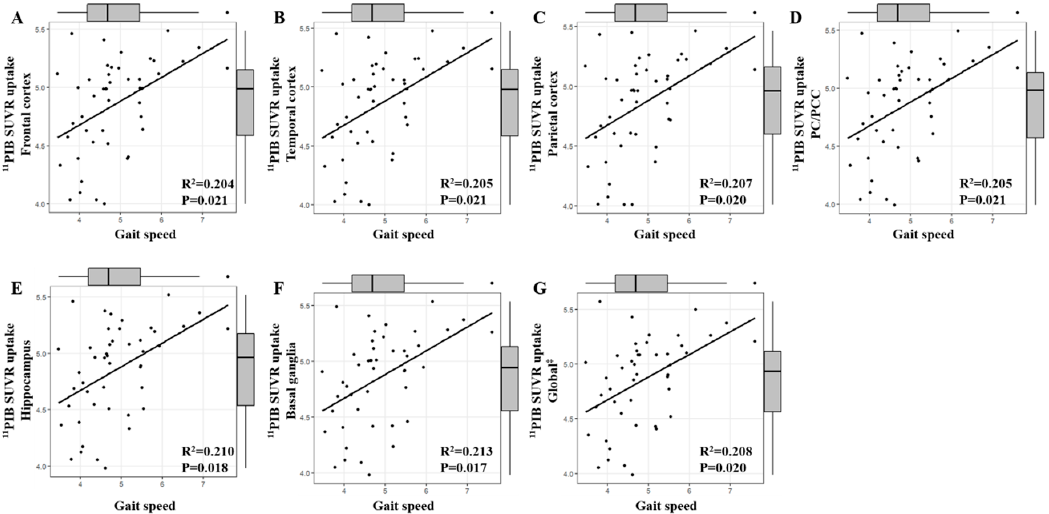
Figure 1. Association between mean Standardized uptake value ratio (SUVR) and gait speed by brain region. Arithmetic mean of frontal cortex, lateral temporal cortex, parietal cortex, precuneus/posterior cingulate cortex (PC/PCC), and basal ganglia SUVR. Adjusted for age and level of education.